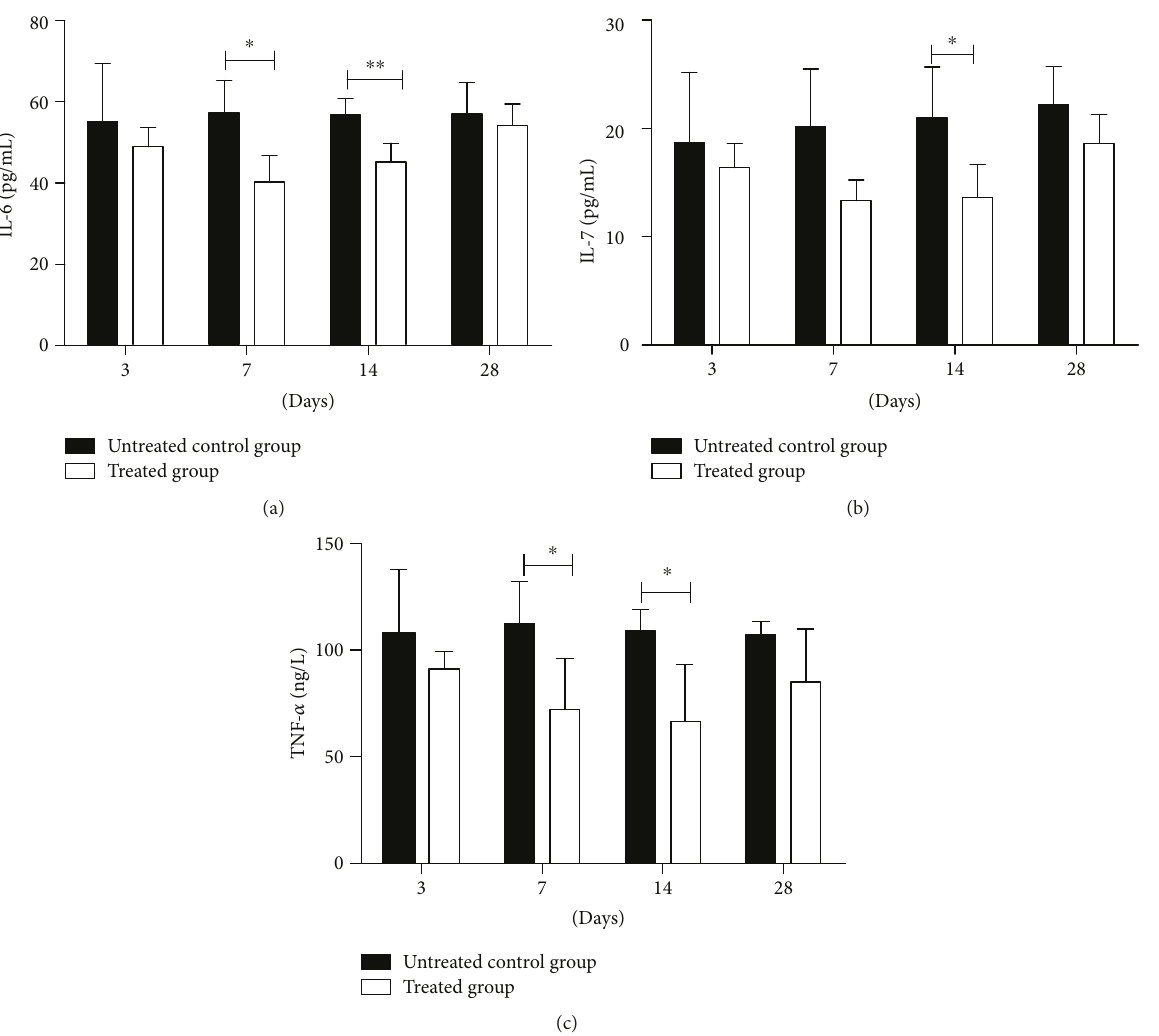
Figure 6: The blood levels of IL-6, IL-7, and TNF- α in dogs (mean ± SD, n = 4 ): (a) the blood level of IL-6 in dogs on days 3, 7, 14, and 28 posttreatment; (b) the blood level of IL-7 in dogs on days 3, 7, 14, and 28 posttreatment; and (c) the blood level of TNF- α in dogs on days 3, 7, 14, and 28 posttreatment. ∗ P < 0 05 and ∗∗ P < 0 01